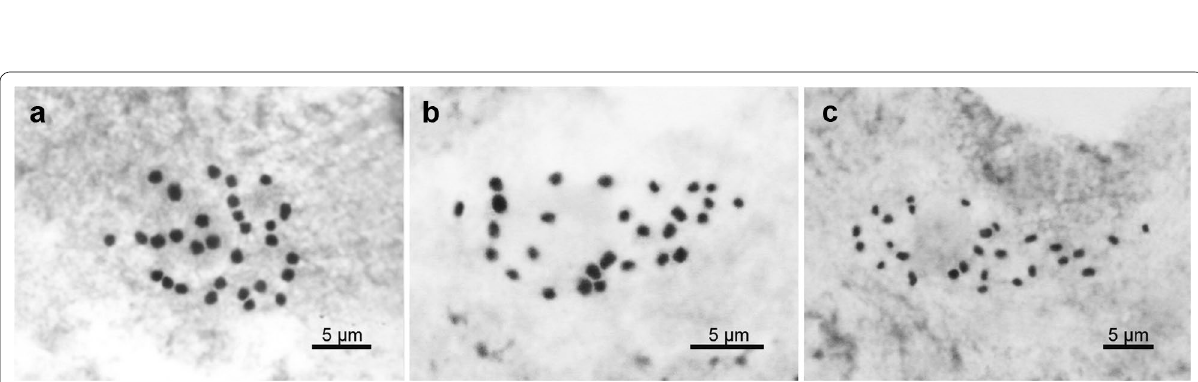
Fig. 9 Somatic chromosomes at metaphase of Begonia . a B. culasiensis (2 n sykakiengii (2 n 28, Peng et al . 23890 =